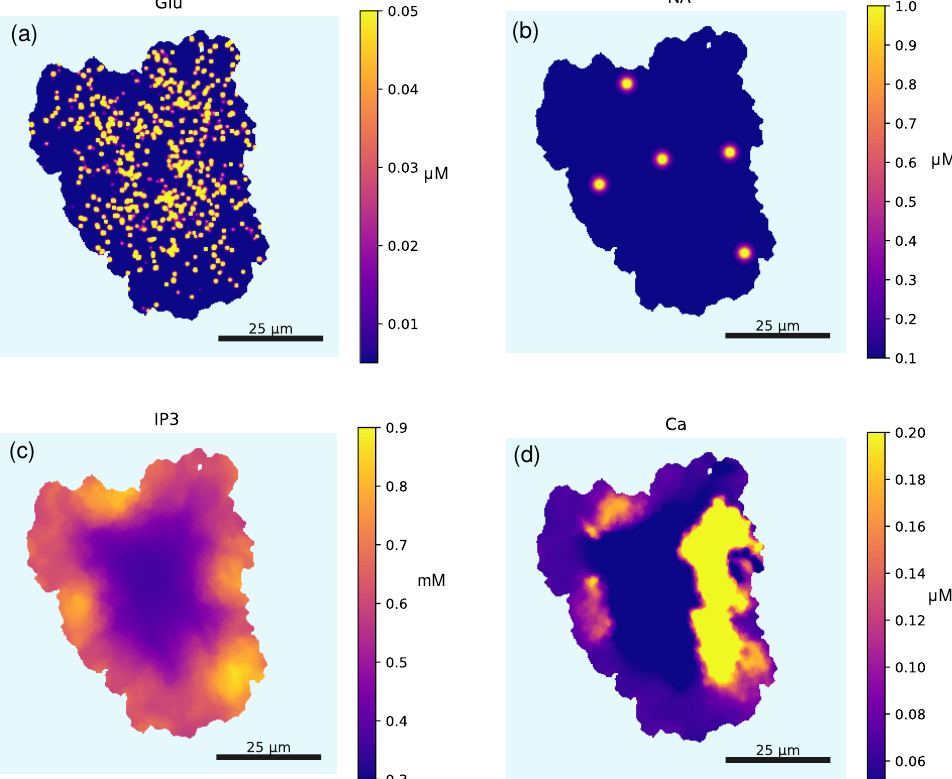
Figure 3. Instantaneous spatial profiles of the principal model variables. Color-coded patterns in panels ( a ), ( b ), ( c ), ( d ) show snapshots of Glu , NA , IP 3 , and Ca 2 + , respectively. Parameter set 1 was